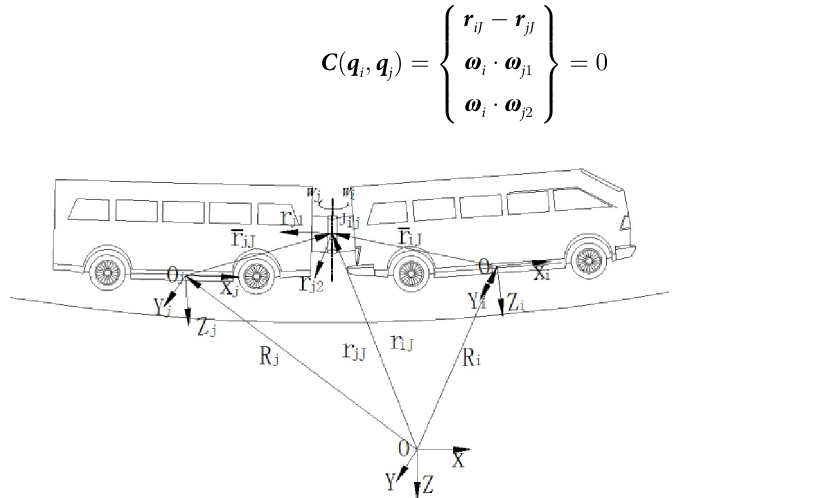
Fig 2. Kinematics constraints of the articulated